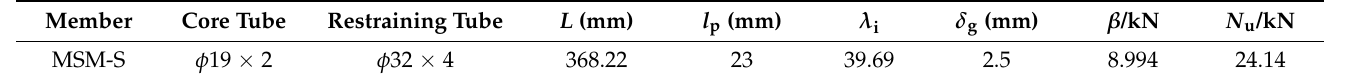
Table 3. The parameters of the substituted buckling monitoring member.